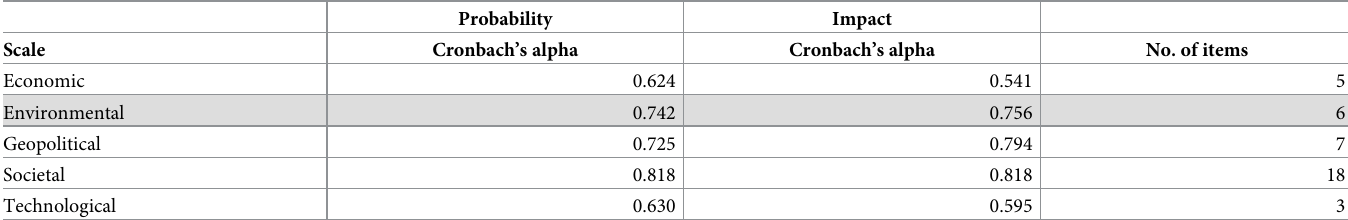
Table 1. Cronbach’s alpha for individual types of risks.